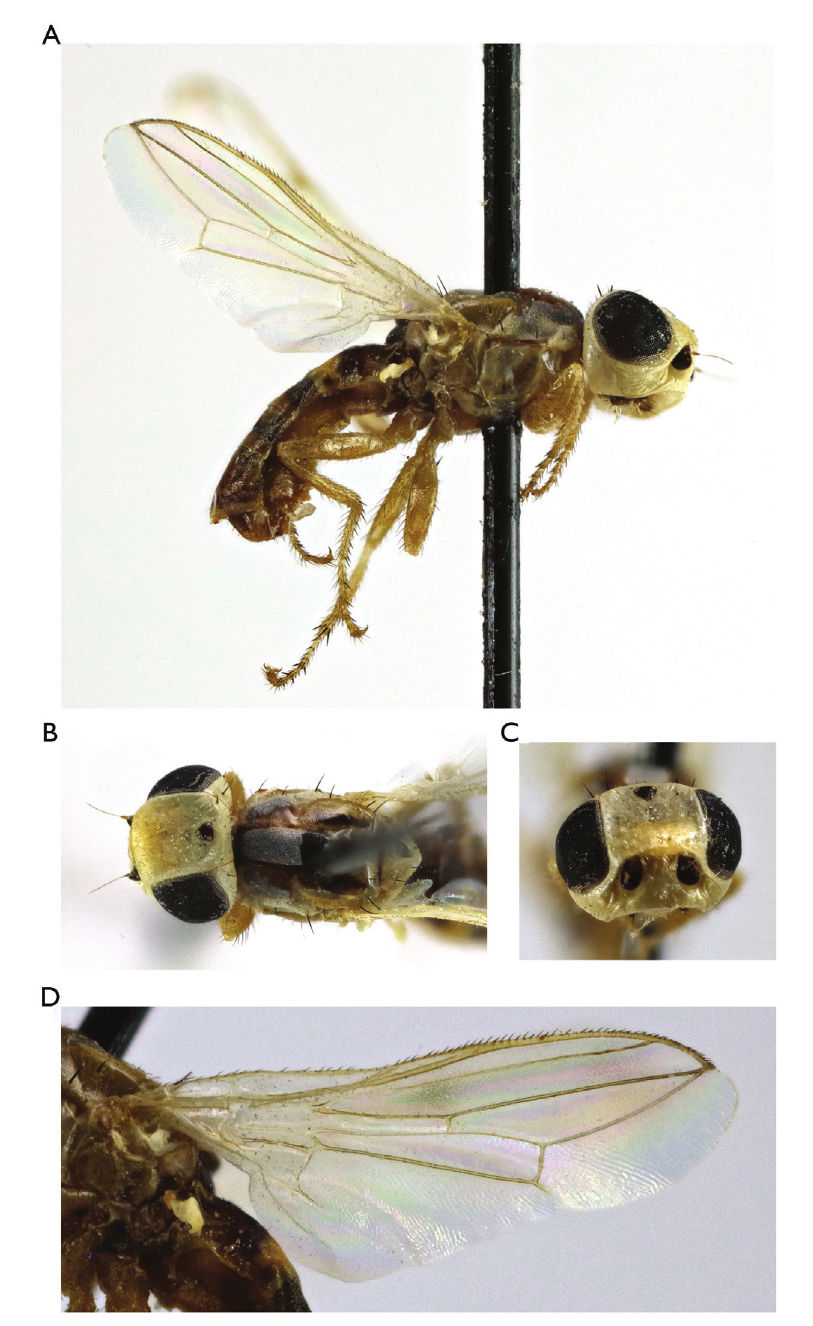
Figure 8. Timia gobica Zaitzev, 1982, male A habitus, lateral view B head and thorax, dorsal view C head, anterior view D